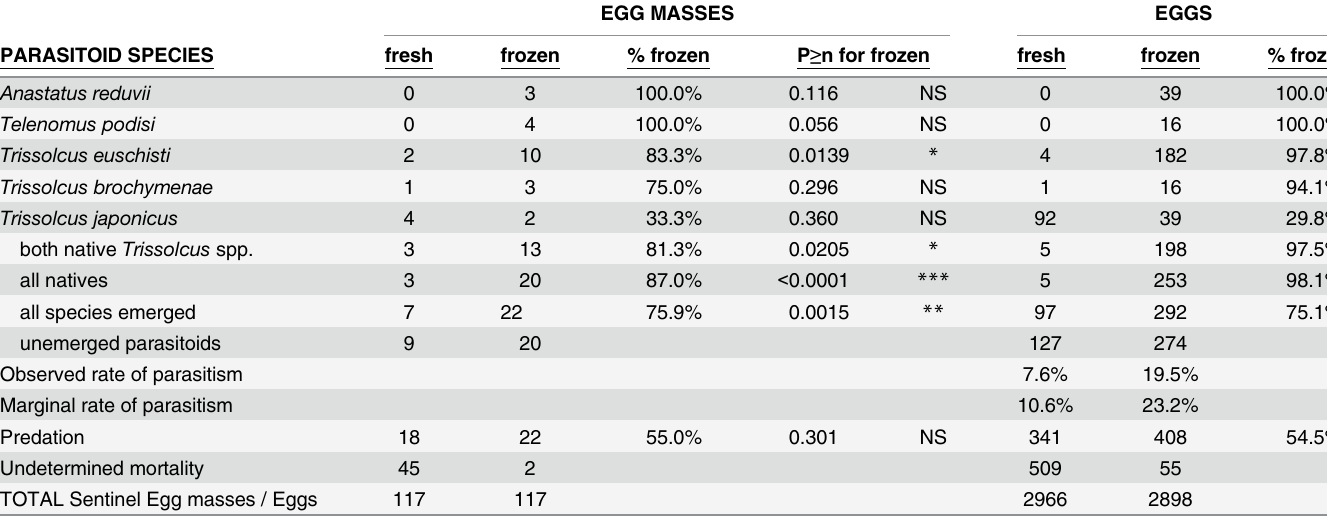
Table 1. Occurrence of successful egg parasitism by species, with tests for differences between fresh and frozen sentinel